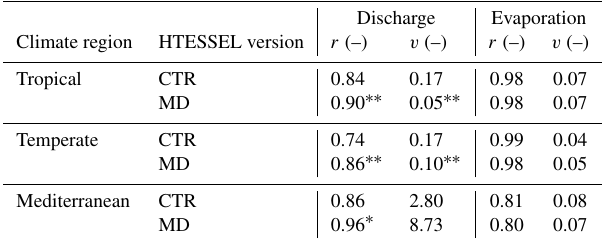
Table 3. Model performance parameters of monthly seasonal dis- charge ( Q ) and evaporation ( E ) climatologies (1975–2010), with r representing Pearson correlation and v = (1 − α ) 2 variability (where α = σ mod /σ obs ), in tropical, temperate and Mediterranean climate regions for the HTESSEL CTR and MD versions (catchment aver- ages). Modeled Q is compared to station observations and modeled E to FLUXCOM-WB (Eq. 1). For r , a value of 1 represents a per- fect model; for v a value of 0 represents a perfect model. The sig- nificance test of the MD improvements compared to CTR is repre- sented by ∗∗ (passing the 5% level) and ∗ (passing the 10% level). Values of r and α for the individual catchments and p values of improvement are shown in Tables S5 ( Q ) and S6 ( E